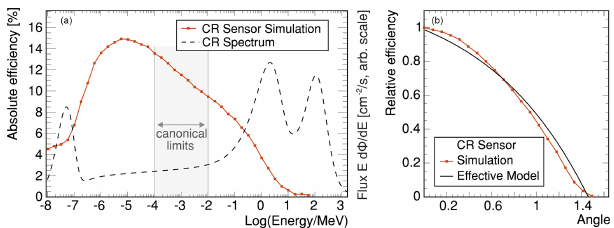
Figure 9. Detection efficiencies for the standard CRNS detector model. (a) Energy-dependent absorption probability for perpendic- ular irradiation, here simulation of a monoenergetic beam with re- sults (red markers) averaged over the surface. (b) Energy indepen- dent, averaged, angular dependence relative to (a)